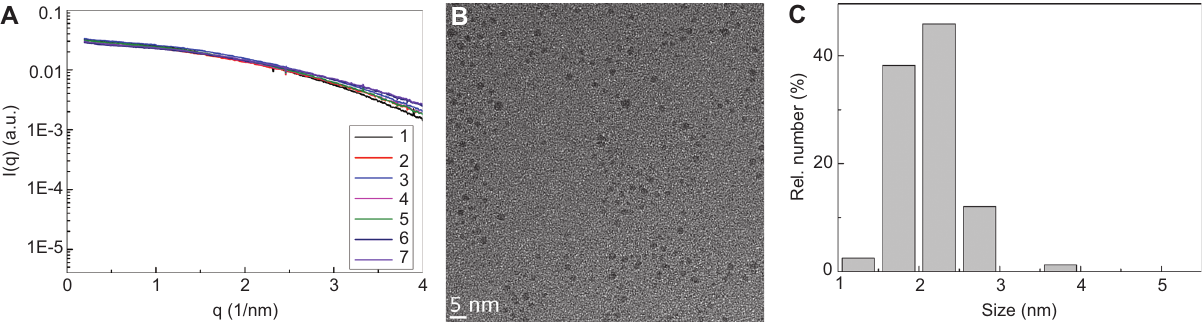
Figure 1 (A) Scattering curves of the different sets of PVP-stabilized Pd NPs. (B) TEM image of a Pd NP sample. Scale bar is 5 nm. (C) Size distribution derived from TEM.